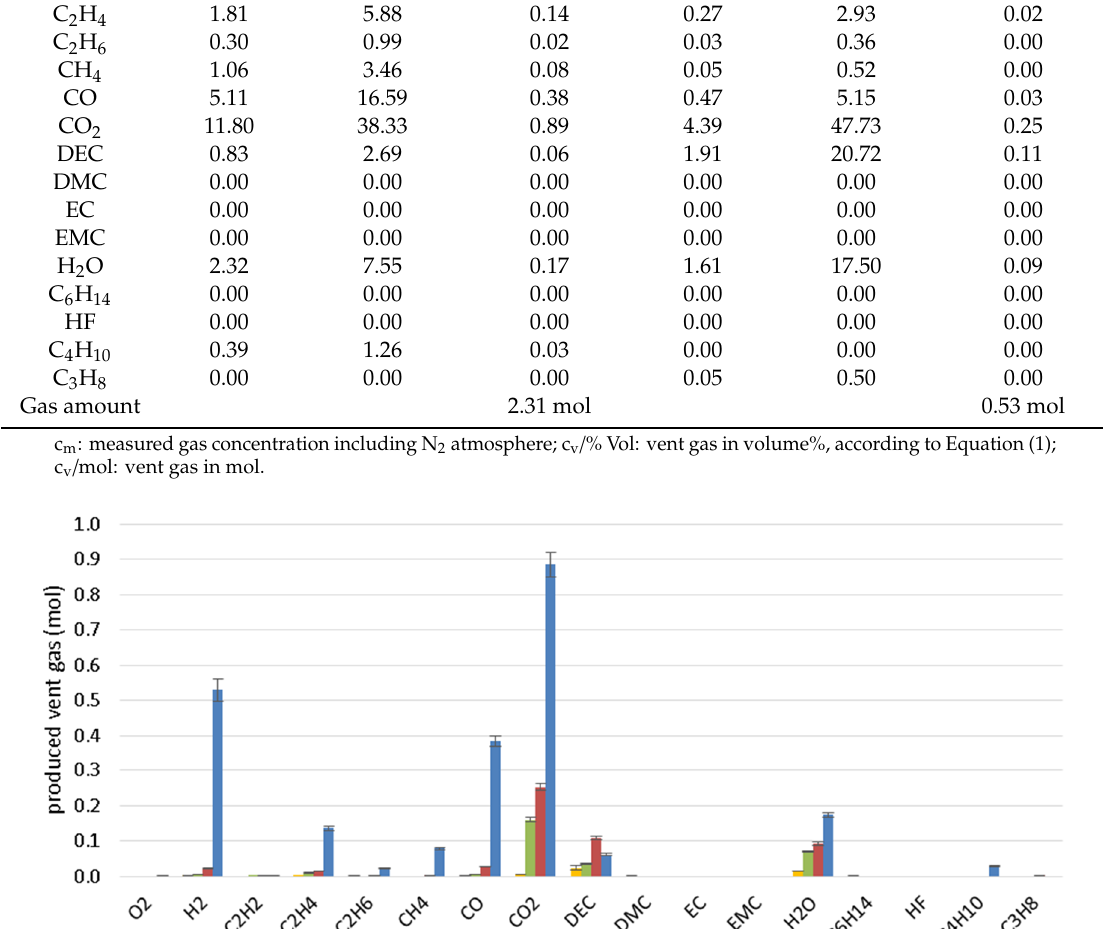
of the 100% cell